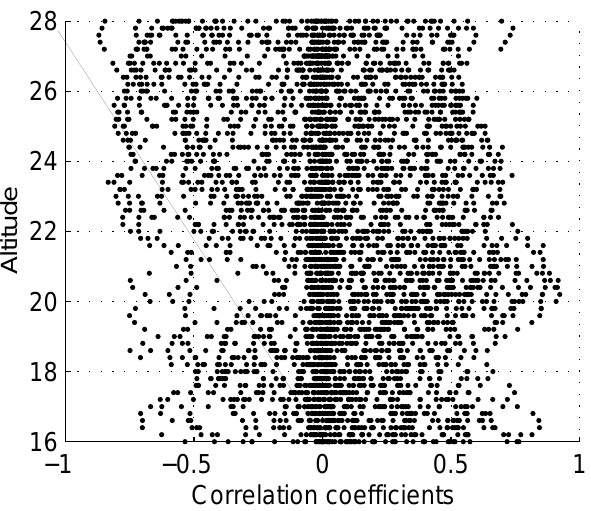
Fig. 4. Correlation coefficients for 128x128-pixel image sub-blocks at 61 projected altitudes (16–28km), showing the presence of an object at 20km in the modelled pair of test